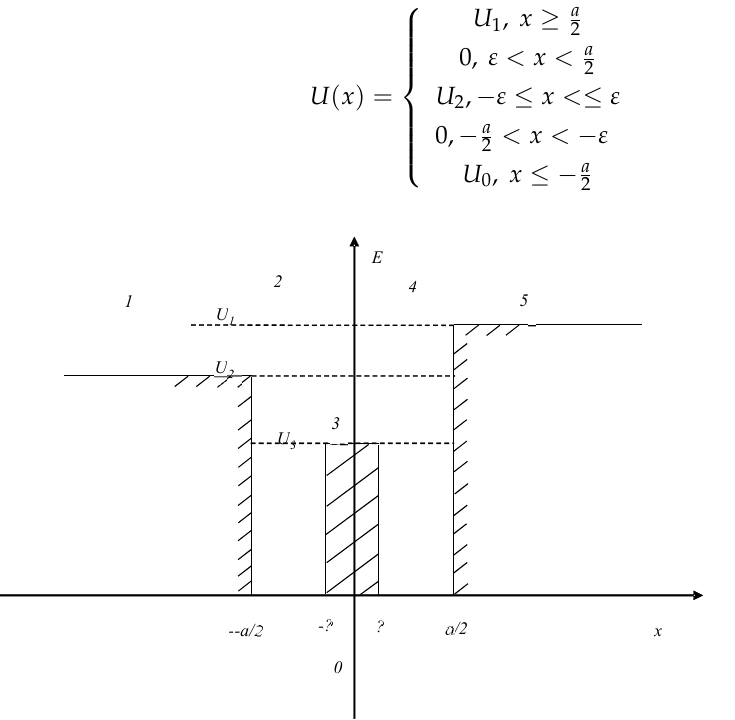
Figure 3. One-dimensional potential well with finite walls. A version with uneven walls and an internal potential barrier.